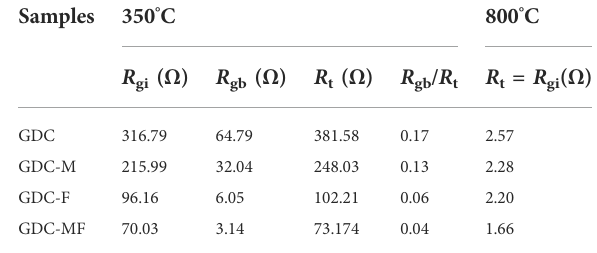
TABLE 2 Resistance of GDC-based electrolytes at 350 and 800 °